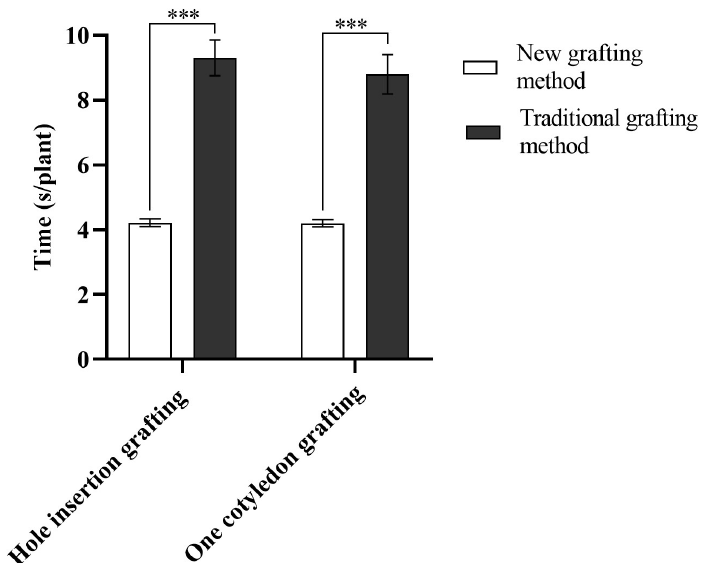
Figure 9. Time used to physically remove the pumpkin rootstock cotyledon epidermis for the new grafting method and the time required to remove rootstock regrowth for the traditional grafting method ( n = 3). *** indicates significant difference at p < 0.001